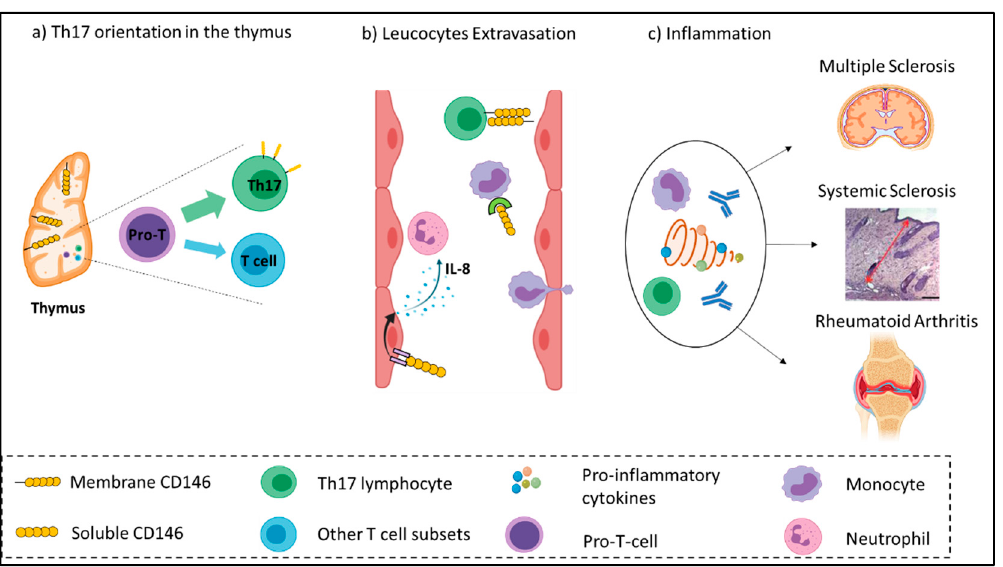
Figure 1. Illustration summarizing the inflammatory role of CD146 in autoimmune diseases. ( a ) CD146 supports thymic development and architecture and promotes the differentiation of naïve T cells from the Th17 subset. ( b ) In the blood compartment, CD146 enhances the adhesion, rolling, and extravasation of lymphocytes and monocytes across the endothelium. The soluble form of CD146 favorizes IL-8 secretion by endothelial cells, which in turn recruit neutrophils. ( c ) Following extravasation, immune effectors produce a storm of inflammatory cytokines, which exacerbate inflammation and subsequently damage target organs such as the Central Nervous System (CNS), skin, and joints.